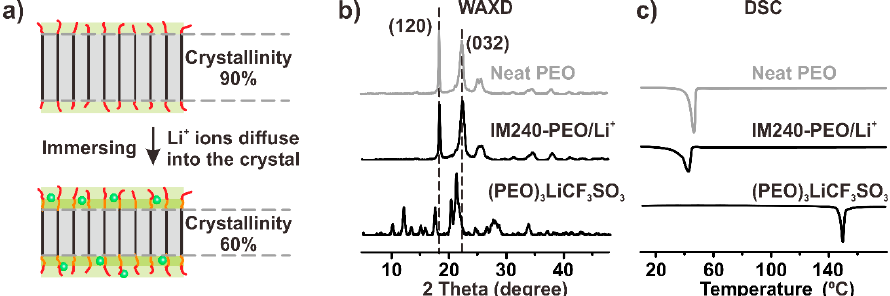
Figure 3. ( a ) Schematic illustrating the immersion process and the Li + ions di ff using into the crystal. The orange lines and red lines denote the PEO amorphous chain segments and chain ends, respectively. The black lines denote the crystalline PEO chains, and the green balls denote the Li + ions. ( b ) The WAXD patterns of neat PEO, IM240-PEO / Li + , and (PEO) 3 LiCF 3 SO 3 . The experimental temperature is room temperature. ( c ) The DSC curves of neat PEO, IM240-PEO / Li + , and (PEO) 3 LiCF 3 SO 3 . The samples were heated from 10 to 180 ◦ C at 10 ◦ C /